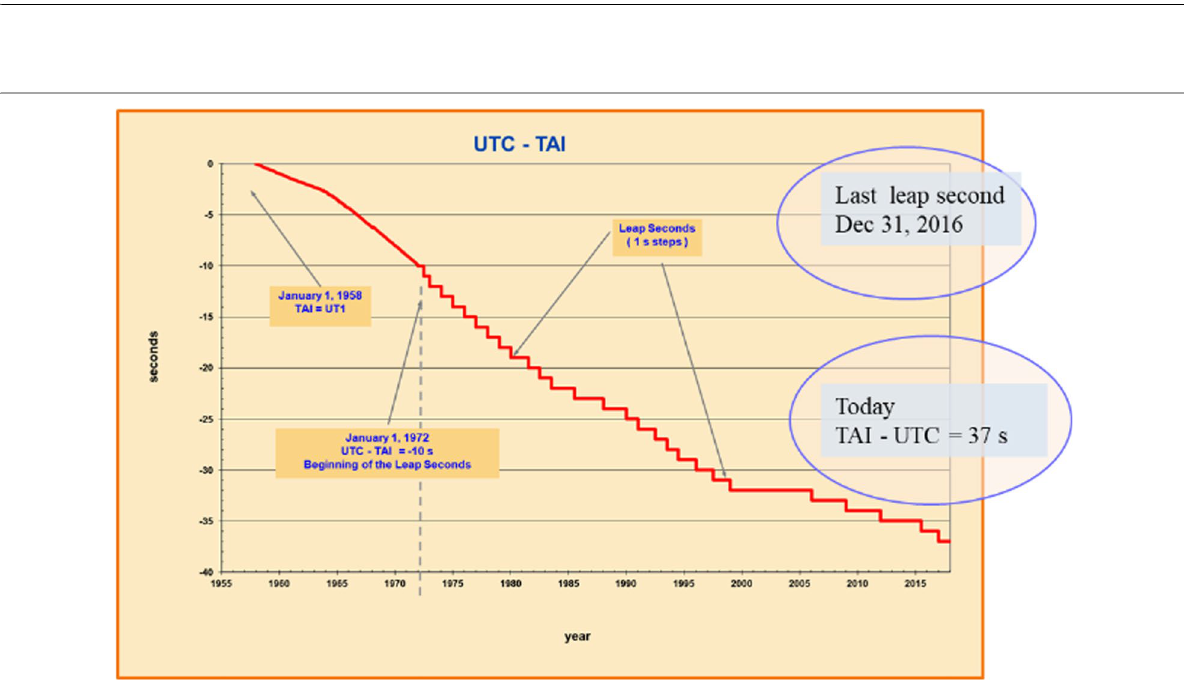
rotational angle was smaller than a second. The offset between UTC and TAI is illustrated in Fig. 8.